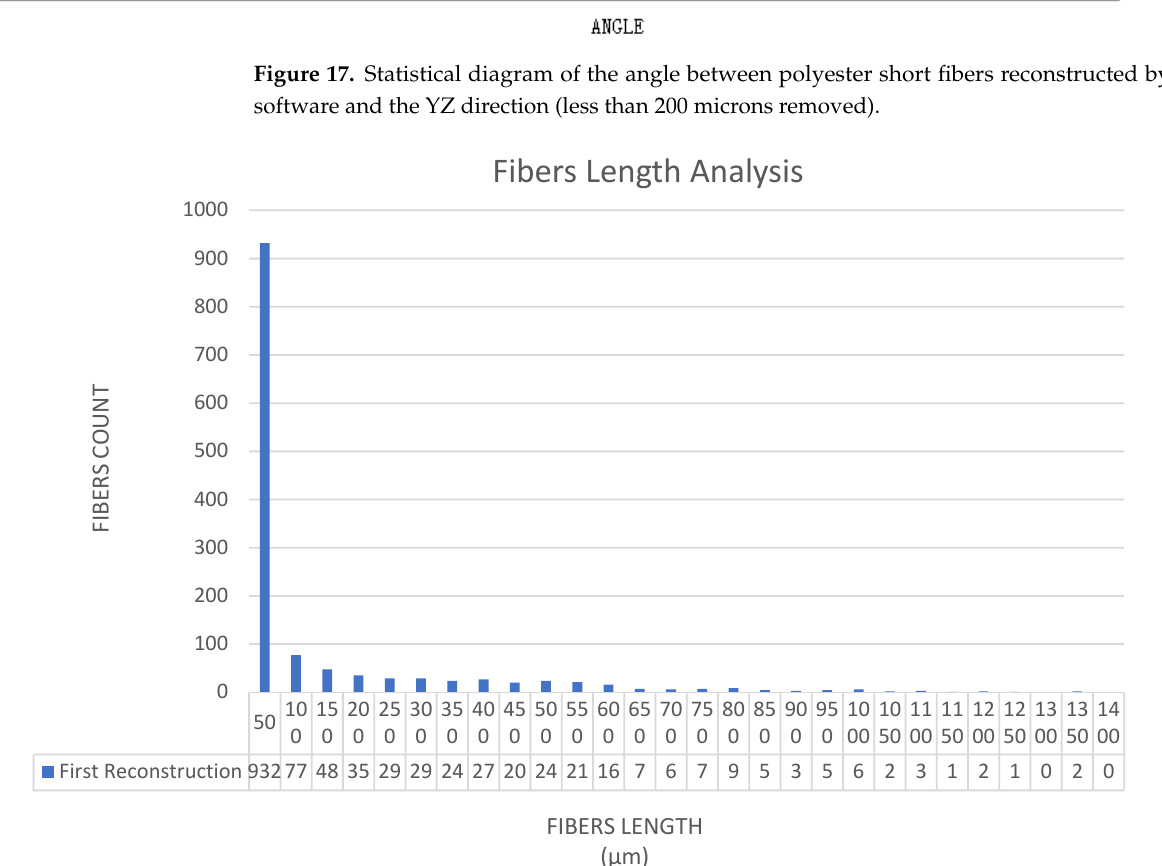
Figure 17. Statistical diagram of the angle between polyester short fibers reconstructed by Avizo software and the YZ direction (less than 200 microns removed).